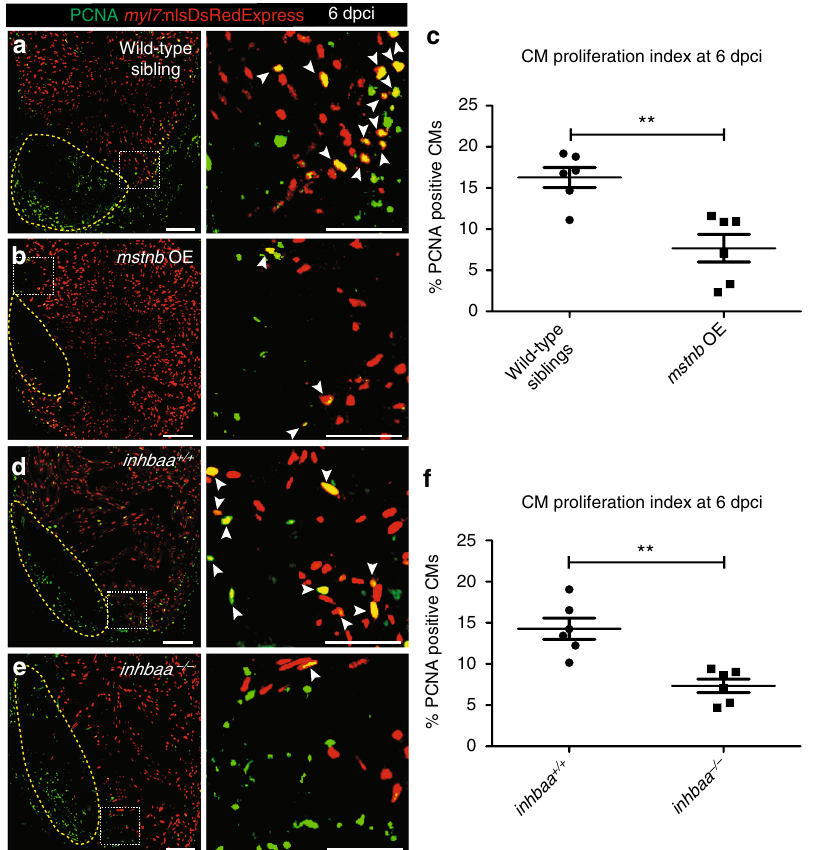
Fig. 2 mstnb GOF and inhbaa LOF suppress CM proliferation during cardiac regeneration. a , b Sections of wild-type sibling and mstnb OE cryoinjured hearts in Tg(myl7:nlsDsRedExpress) background at 6 dpci; α -DsRed (red), PCNA (green). Yellow dotted regions delineate the injured area. Higher magni fi cations of dashed boxes in a , b are shown on right side. White arrowheads point to proliferating CMs (PCNA + /DsRed + ). c Quanti fi cation of CM proliferation in wild- type sibling ( n = 6) and mstnb OE ( n = 6) cryoinjured hearts in the 100 µ m region adjacent to the injured area at 6 dpci. d , e Sections of inhbaa + / + and inhbaa − / − cryoinjured hearts in Tg(myl7:nlsDsRedExpress) background at 6 dpci; α -DsRed (red), PCNA (green). Higher magni fi cations of dashed boxes in d , e are shown on right side. f Quanti fi cation of CM proliferation in inhbaa + / + ( n = 6) and inhbaa − / − ( n = 6) cryoinjured hearts in the 100 µ m region adjacent to the injured area at 6 dpci. All cell counts were performed on three sections from each heart. Each data point on dot plot represents one heart (data are mean ± s.e.m., ** P ≤ 0.01 — Student ’ s t test, two-tailed). Scale bars: heart sections, 100 µ m; higher magni fi cations, 50 µ